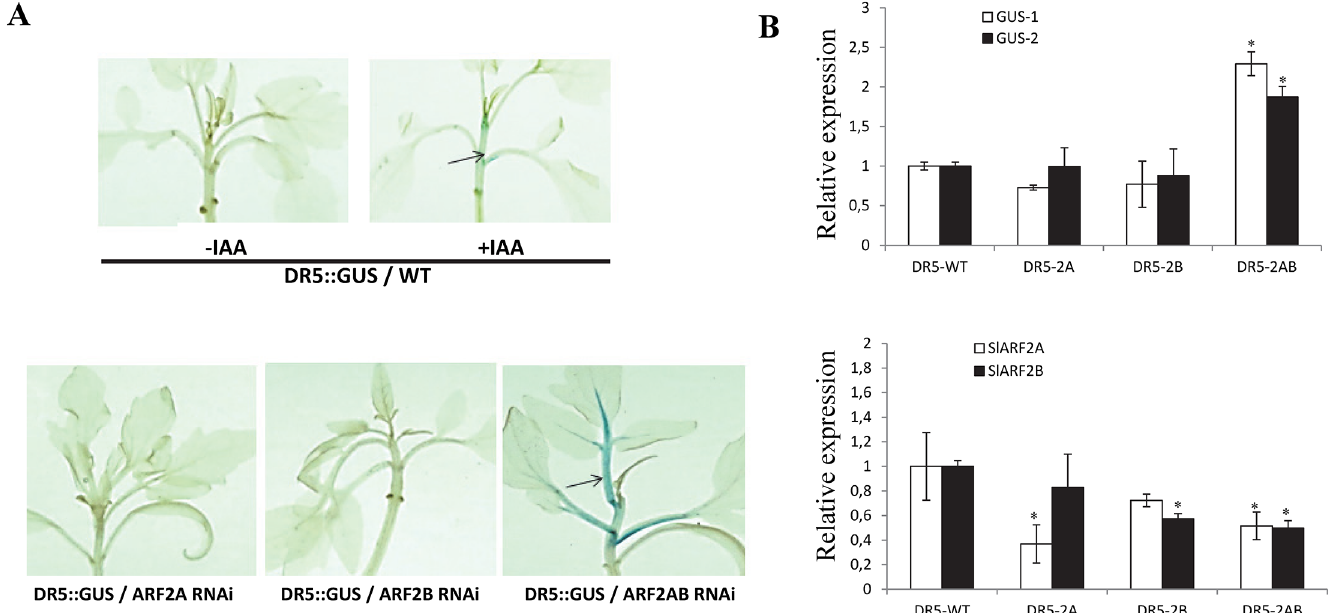
Fig 5. Impact of the down-regulation of SlARF2A and SlARF2B on auxin response assessed in planta following genetic crosses between DR5:: GUS and SlARF2 down-regulated lines. (A) Expression pattern of the GUS reporter gene under the control driven by the auxin-inducible DR5 promoter in wild type (WT) and SlARF2 down-regulated genetic background. Seedlings were treated with auxin (IAA 20 μ M for 3 hours) or with a mock solution. Upper panel: in planta expression of the GUS reporter gene driven by DR5 in WT genetic background in the absence (left) or presence (right) of auxin treatment. Bottom panel: Expression of the GUS reporter gene driven by DR5 in ARF2A RNAi (left), ARF2B RNAi (middle) and ARF2AB RNAi (right) genetic background. (B) Quantitative RT-PCR expression analysis of GUS and SlARF2A/2B genes in WT and SlARF2A and SlARF2B-RNAi lines crossed with DR5:: GUS lines. The relative mRNA levels of GUS-1/GUS-2 (Upper panel) and SlARF2A/2B (bottom panel) in wild type were standardized to 1.0, referring to the SlActin gene as internal control. Error bars mean ± SD of three biological replicates. * 0.01 < p-value < 0.05. DR5-WT = DR5::GUS/WT; DR5-2A = DR5::GUS/ ARF2A RNAi; DR5-2B = DR5::GUS/ARF2B RNAi; DR5-2AB = DR5::GUS/ARF2AB RNAi. GUS-1 and GUS-2 refer to the use of two distinct pairs of primers designed in two distinct regions of the GUS mRNA sequence.